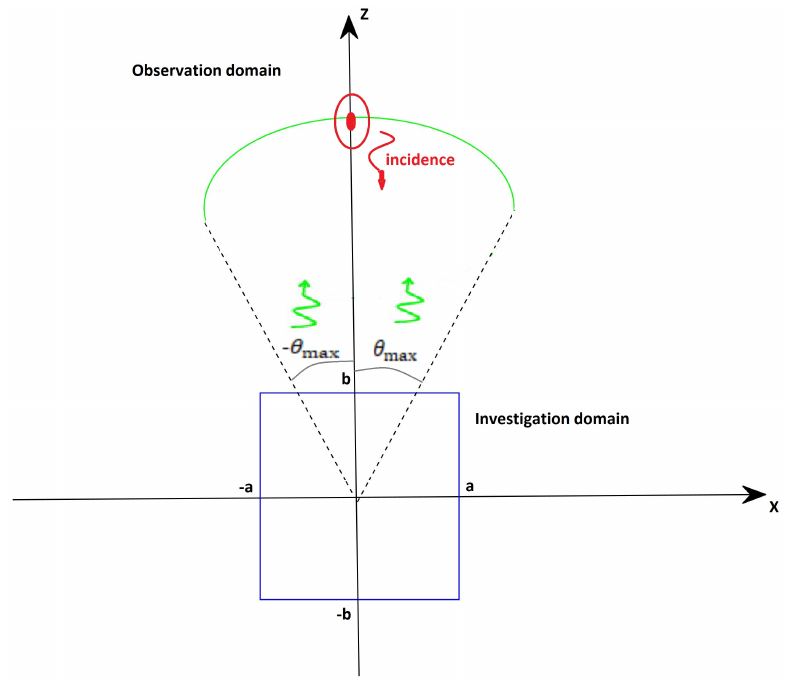
Figure 1. Considered